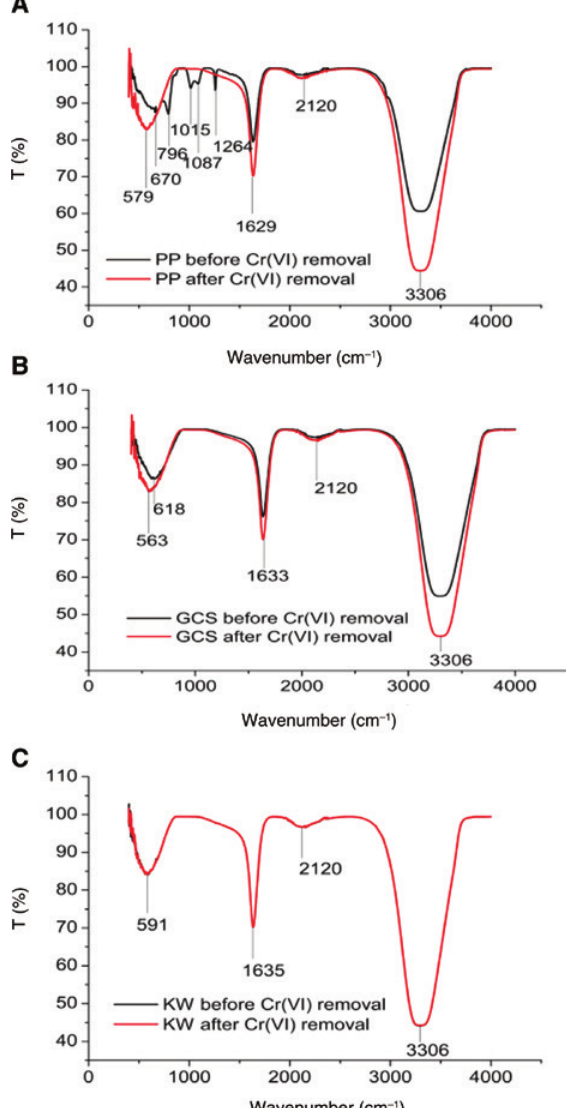
Figure 6: FTIR spectrum of (A) PP, (B) GCS, and (C) KW before and after treatment with Cr(VI) at 303 K and pH